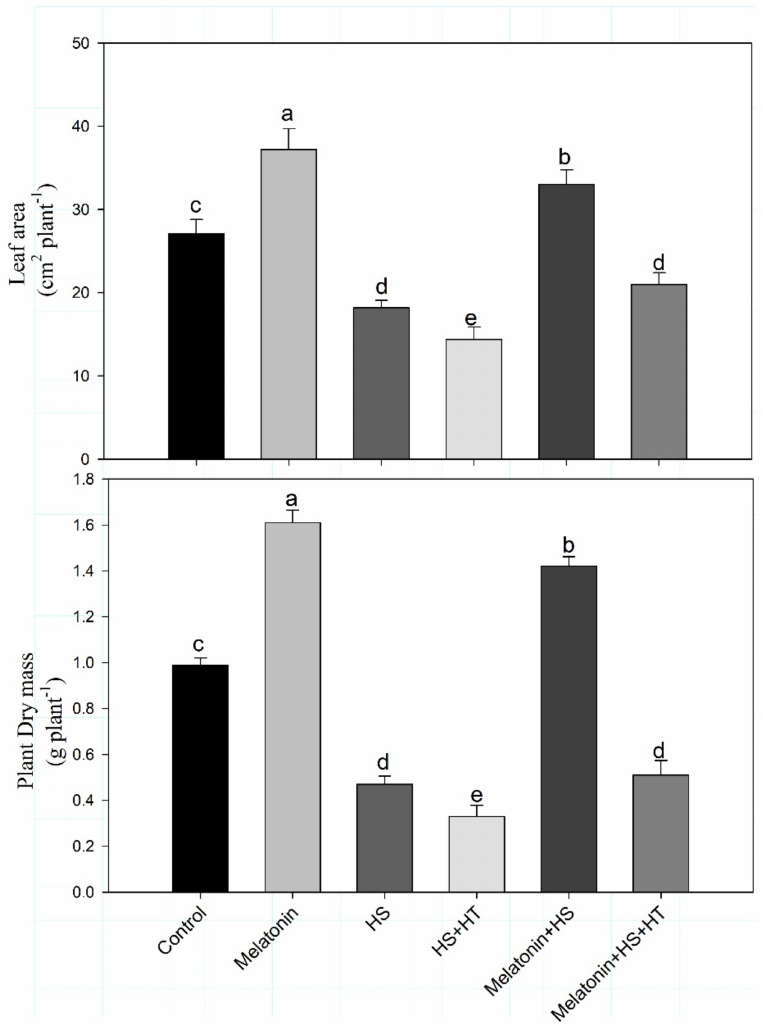
Figure 1. Leaf area and plant dry mass of wheat ( Triticum aestivum L. var. WH 542) at 30 days after sowing (DAS). Plants were treated with melatonin (100 µ M) and/or HT (100 µ M) in the presence (40 ◦ C) or absence (25 ◦ C) of heat stress. Data are presented as means ± SE ( n = 4). Data followed by the same letter are not significantly different by LSD test at p < 0.05. HS, heat stress; HT; hypotaurine. Heat stress declined net photosynthetic rate, stomatal conductance, intercellular CO 2 concentration by 31.2%, 38.4% and 29.5%, respectively, in comparison to control. In contrast, melatonin increased net photosynthetic rate, stomatal conductance and intercellular CO 2 concentration by 18.7%, 38.1% and 22.8% under no stress, and 11.7%, 17.5% and 10.4%, respectively, under heat stress in comparison with the untreated control plants (Figure